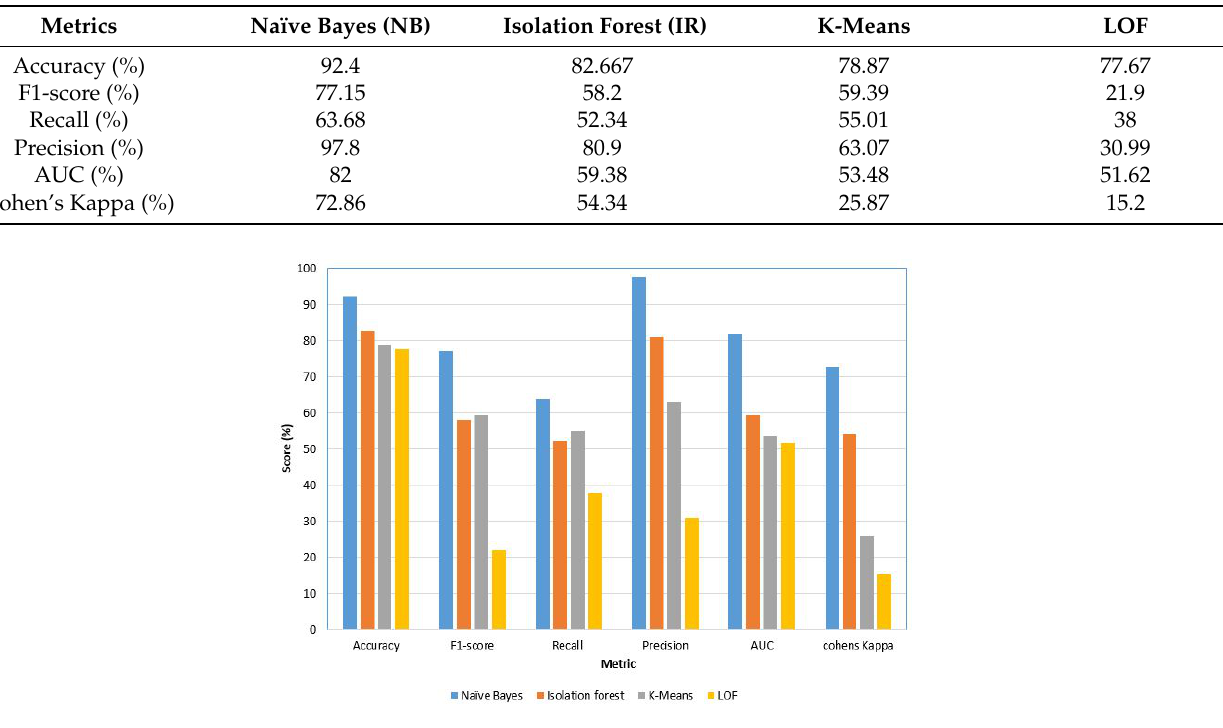
Figure 5. Performance of BR/EDR–Unsupervised ML algorithms. This result shows that the dataset does not show any deviation irrespective of different models (i.e., the dataset is preprocessed intensively).